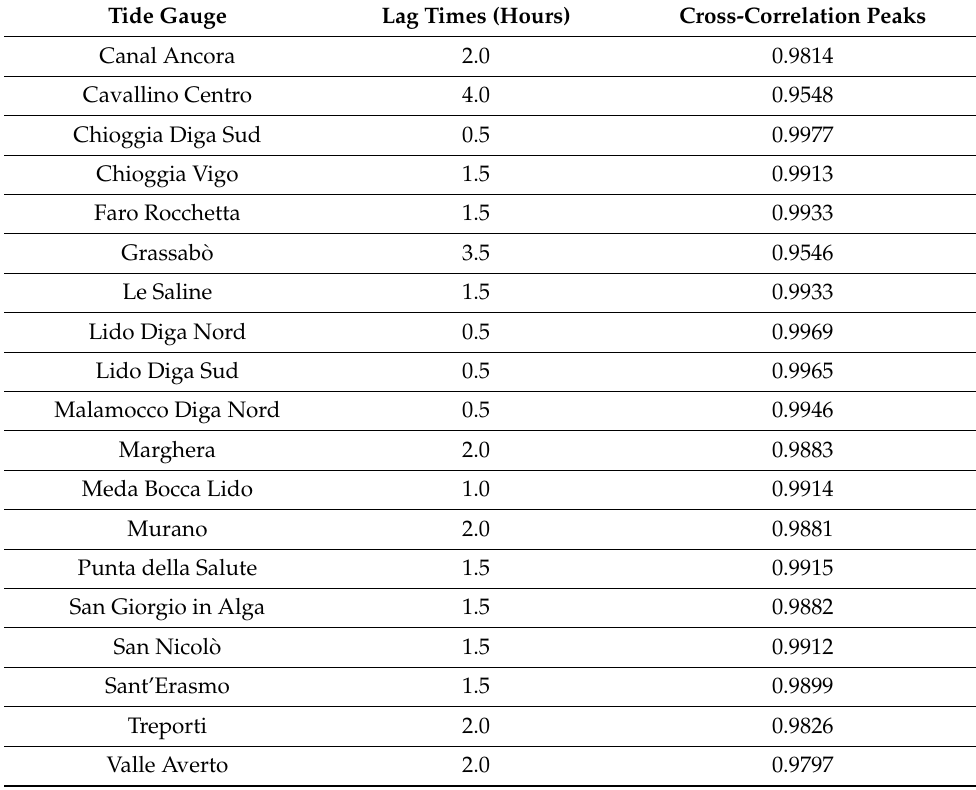
Table 3. Lag times and cross-correlation